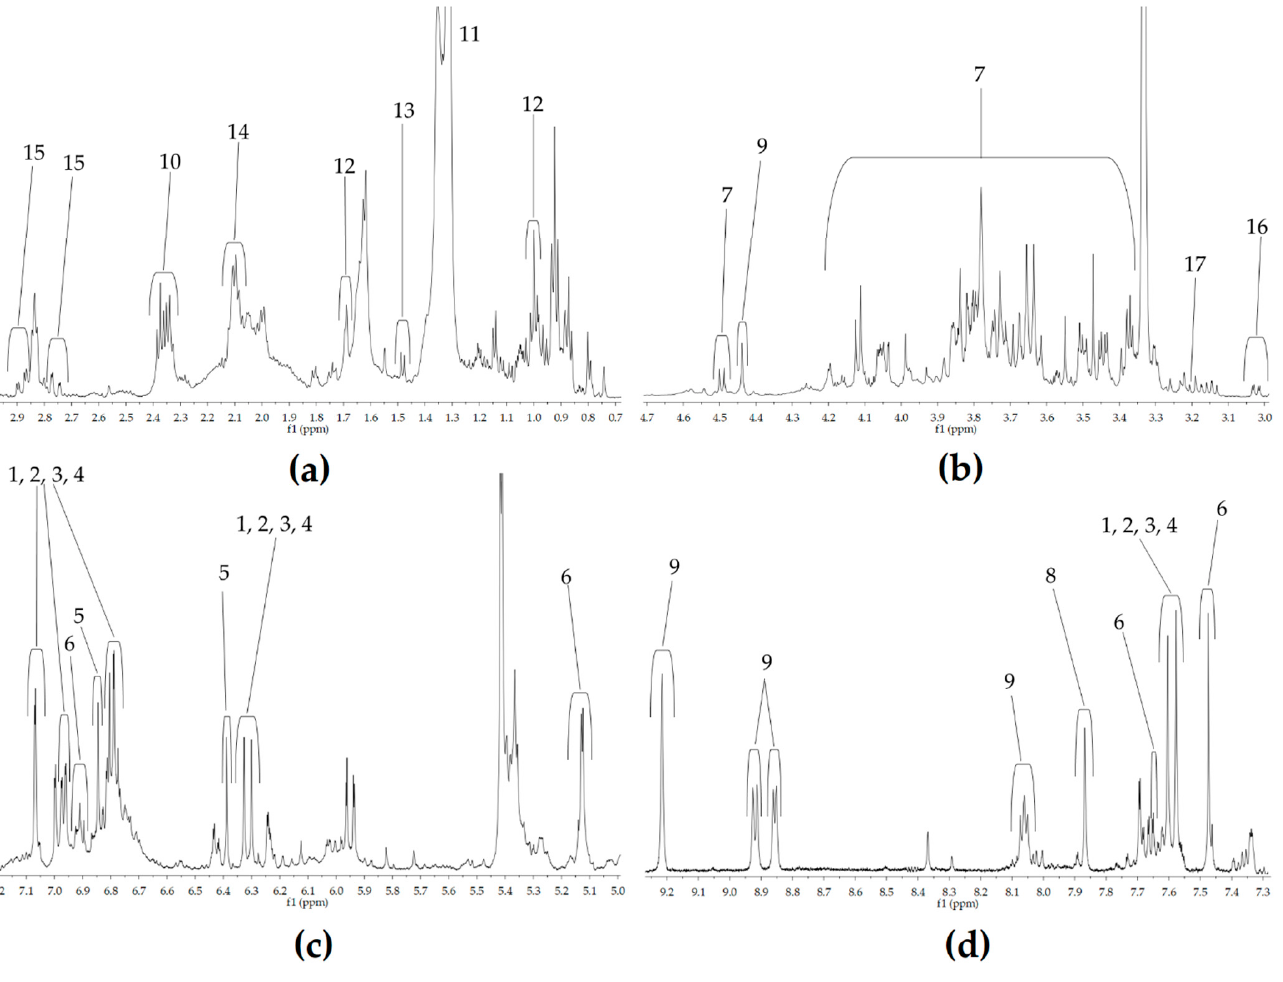
Figure 2. Magnification of the four main section of the 1 H NMR spectrum of C. arabica L. leaf extract: ( a ) 0.0–3.0 ppm, ( b ) 3.0–5.0 ppm, ( c ) 5.0–7.2 ppm, ( d ) 7.3–9.3 ppm.